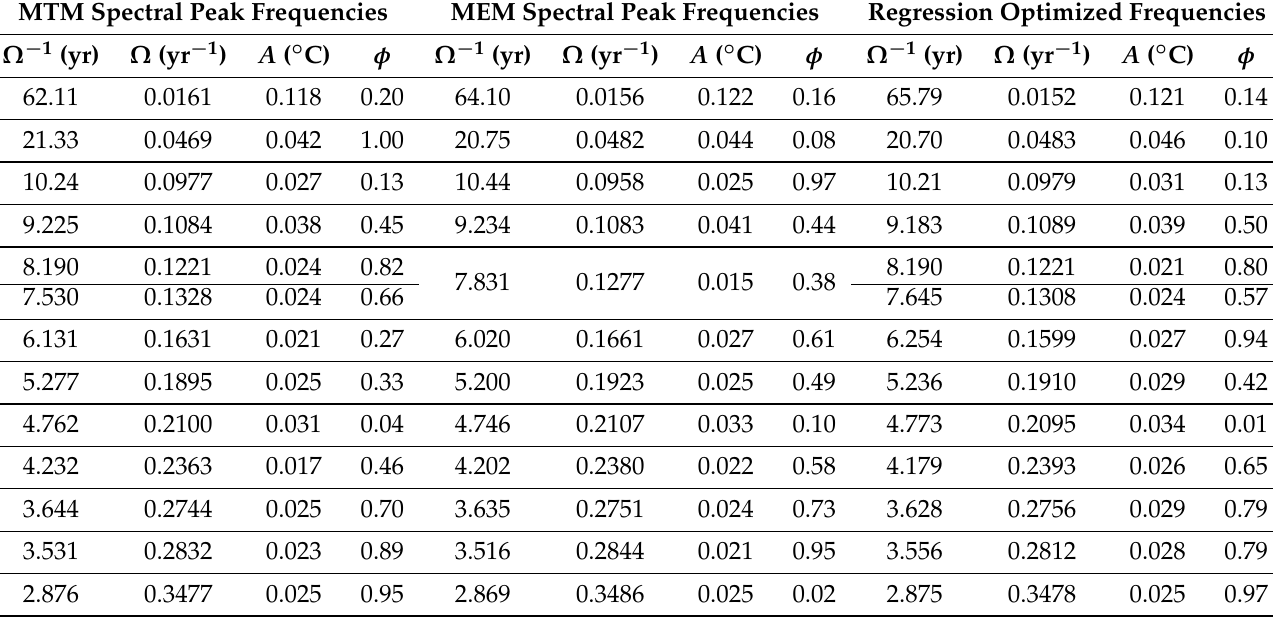
Table 1. Regression coefficient of Equation (1) using the temperature MTM and MEM spectral peaks with a 99% con- fidence level depicted in Figure 3A and after a regression optimization of the frequencies. For a 153-year long se- quence the spectral resolution is d Ω = 1/153 = 0.0065 yr − 1 and the statistical error in the reported frequencies is ∇ Ω = ± 0.5 d Ω = ± 0.003 yr − 1 . The three sets of frequencies are compatible within their statistical error. Ω − 1 is the period, Ω is the frequency, A is the amplitude of the sine wave and φ is the